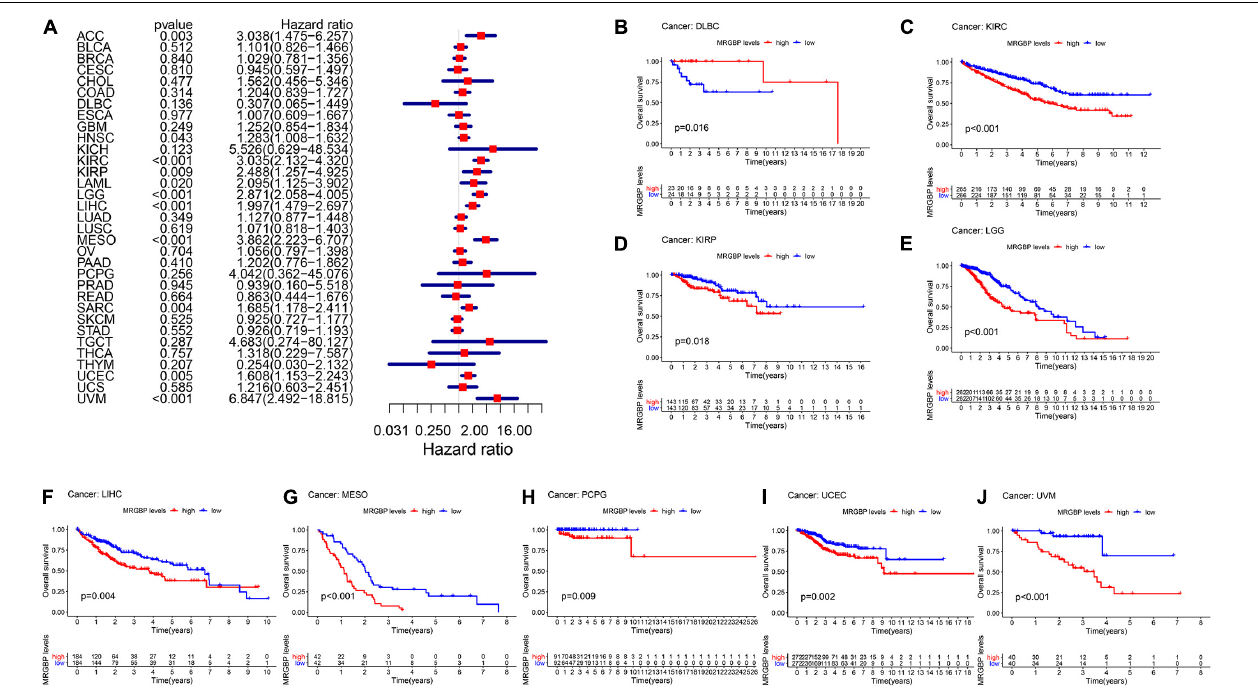
FIGURE 2 | Relationship between MRGBP expression and overall survival (OS) in 33 tumors. The forest plots were calculated using univariate Cox regression (A) and the survival curves were calculated using Kaplan-Meier survival methods (B–J) .